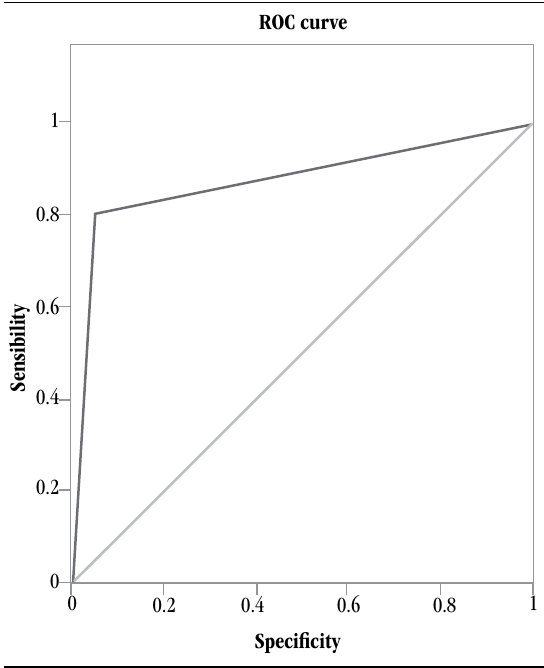
figurE – ROC curve for diagnostic accuracy in FNA and pathological examination of the thyroid ( n = 261) ROC: receiver operating